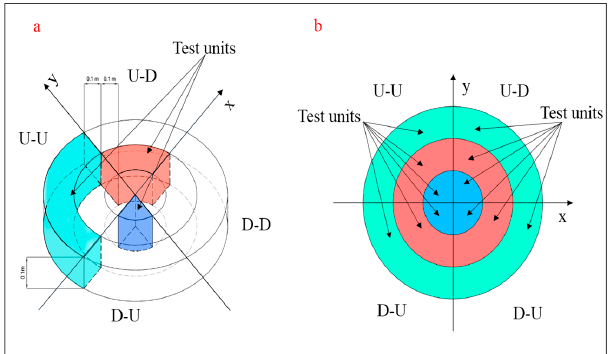
Figure 4. Schematic diagram of the test units. ( a ) 3D schematic of the test units; ( b ) top view of the test units. The intersection of the X-axis and the Y-axis is the center of the stem. This figure shows only the shape of the test unit. The morphological measurement range of the root includes the whole root system, and the test depth for the soil shear strength is 0.6 m below the surface.